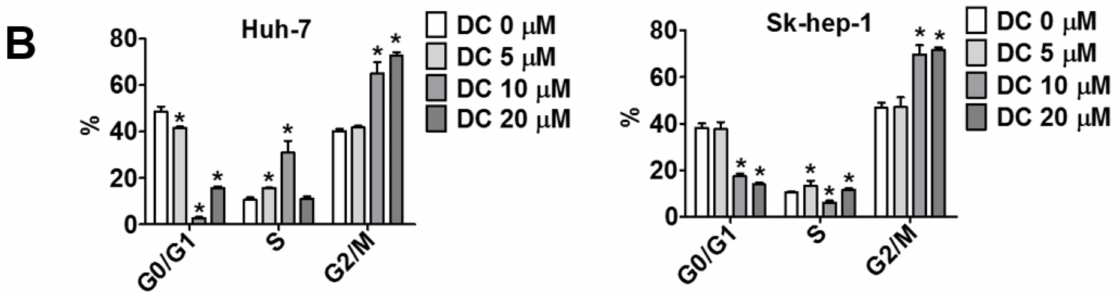
Figure 2. Dehydrocrenatidine induced cell cycle arrest in the G2/M phase in hepatoma cell lines. ( A ) The Huh-7 and Sk-hep-1 cells were assessed by flow cytometry after propidium iodide (PI) staining with indicated concentrations of 0, 5, 10, and 20 µ M of Dehydrocrenatidine after 24 h. ( B ) Quantitative analysis of cell cycle data about G0/G1, S, G2/M of Huh-7 and Sk-hep-1 cells. Student’s t test was applied to determine statistical significance in three experiment. * represented p < 0.05, compared with the control